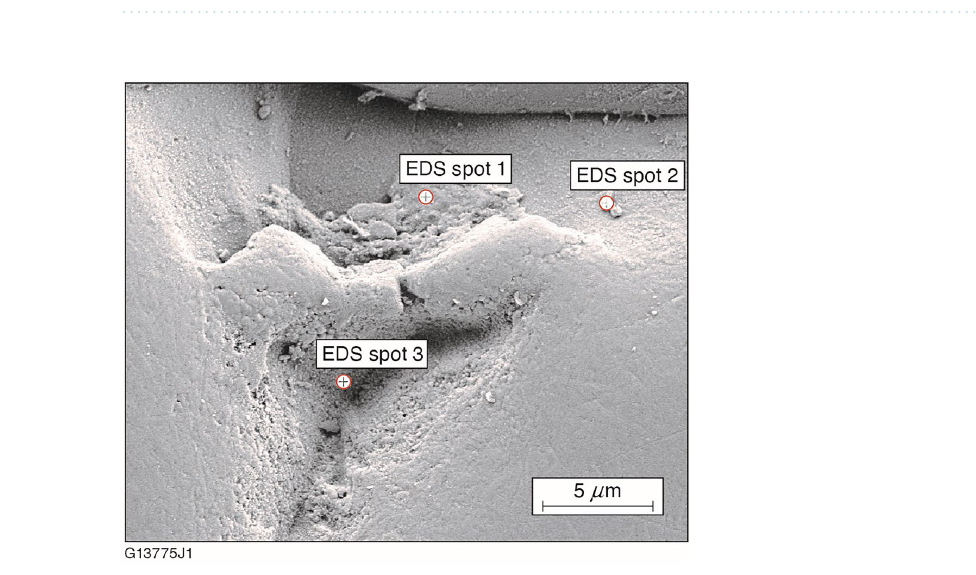
Table 3. Elemental analysis by SEM/EDS of an FJP-induced fracture pit as compared to the remainder of the surface.